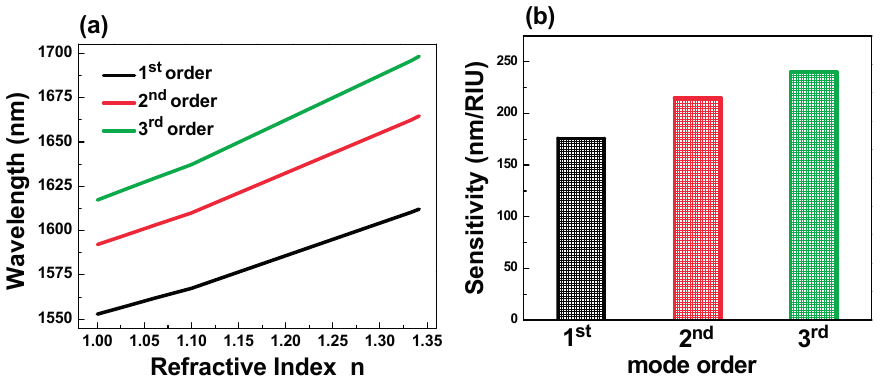
Figure 3. ( a ) Refractive index n versus wavelength shift ∆λ ; ( b ) sensitivity (S = Δλ / Δ n ) for (first, second, and third) modes for the single PhC